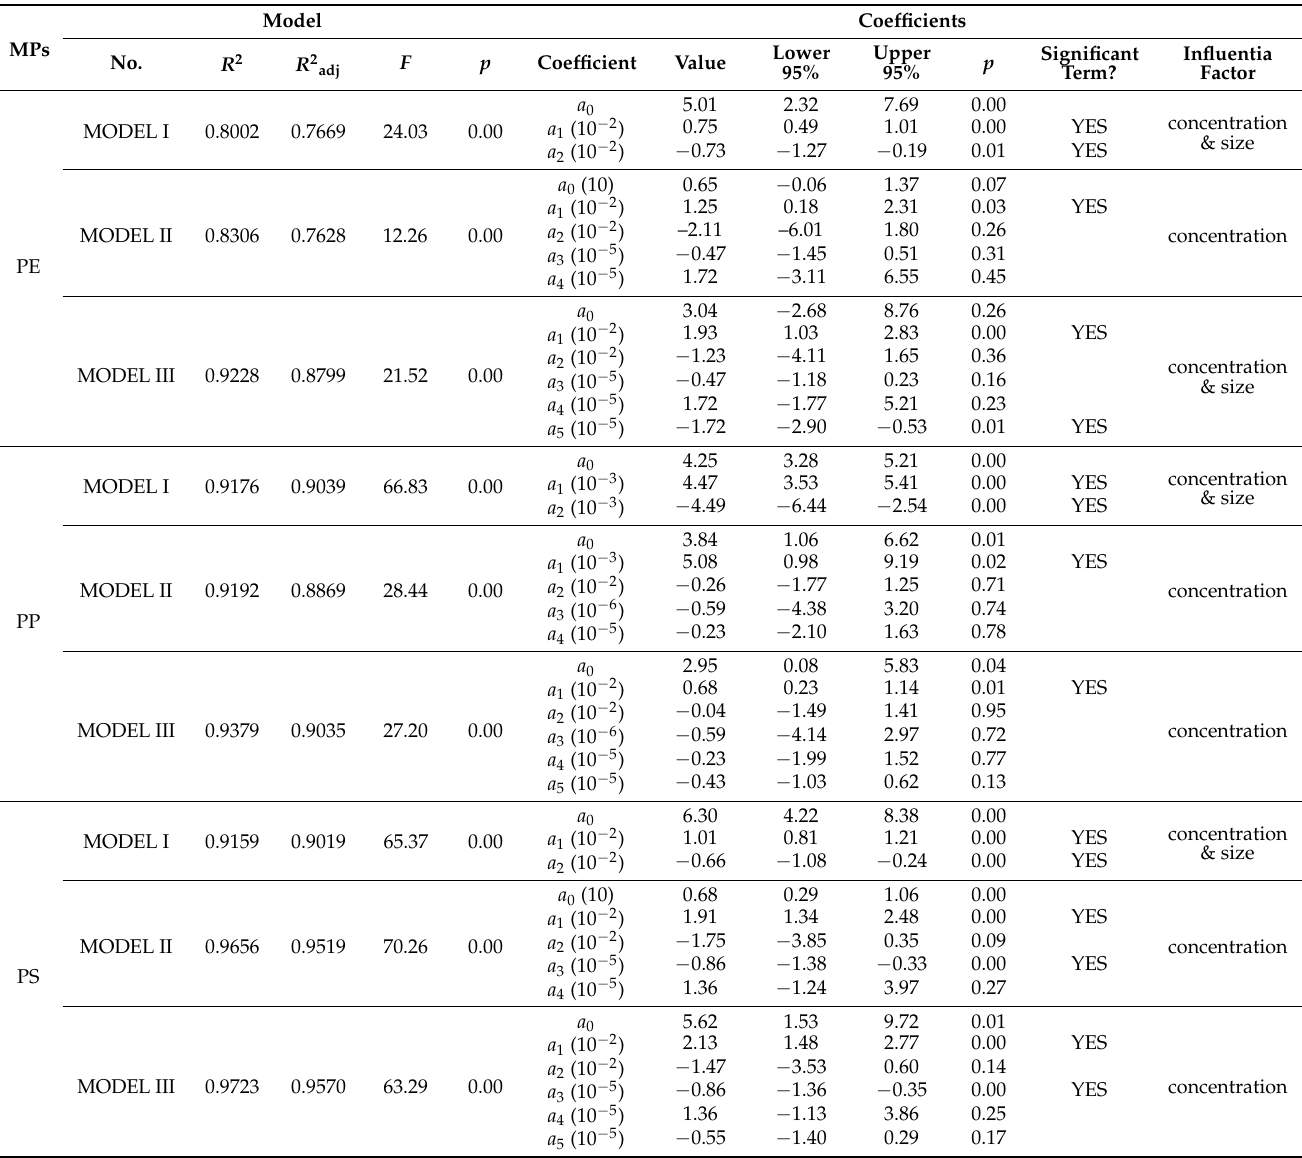
Table 3. Statistical analysis of the regression models (Equations (3)–(5)) for the bacteria Pseudomonas putida . The bacteria were exposed to microplastics (MPs) particles of: polyethylene (PE), polypropylene (PP), polystyrene (PS), polyvinyl chloride (PVC), and polyethylene terephthalate (PET). The analyzed factors were concentration and size of the